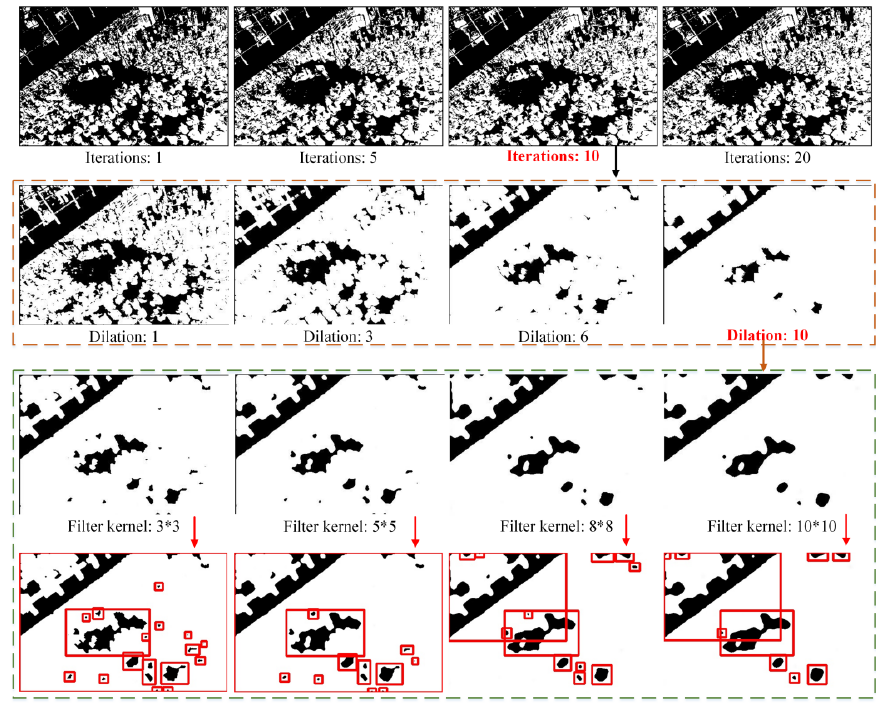
Figure 10. The different results with different parameters of K-means++, dilation algorithm, and the median filtering algorithm.